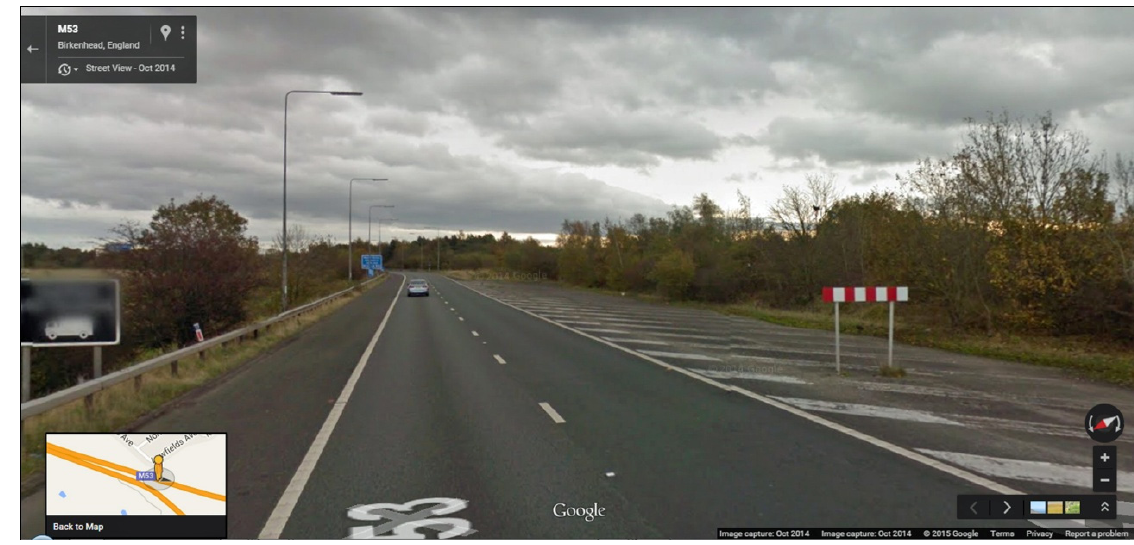
Figure 13. View approaching the island on the southbound carriageway (Map data: © Google